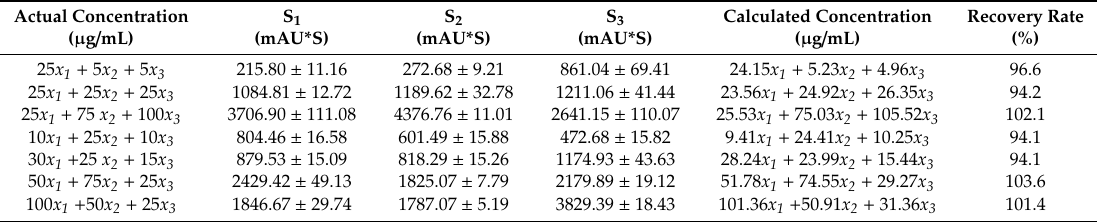
Table 3. Calculation and verification of the quantitative analysis model of mixed astaxanthin. Actual Concentration ( µ g / mL)